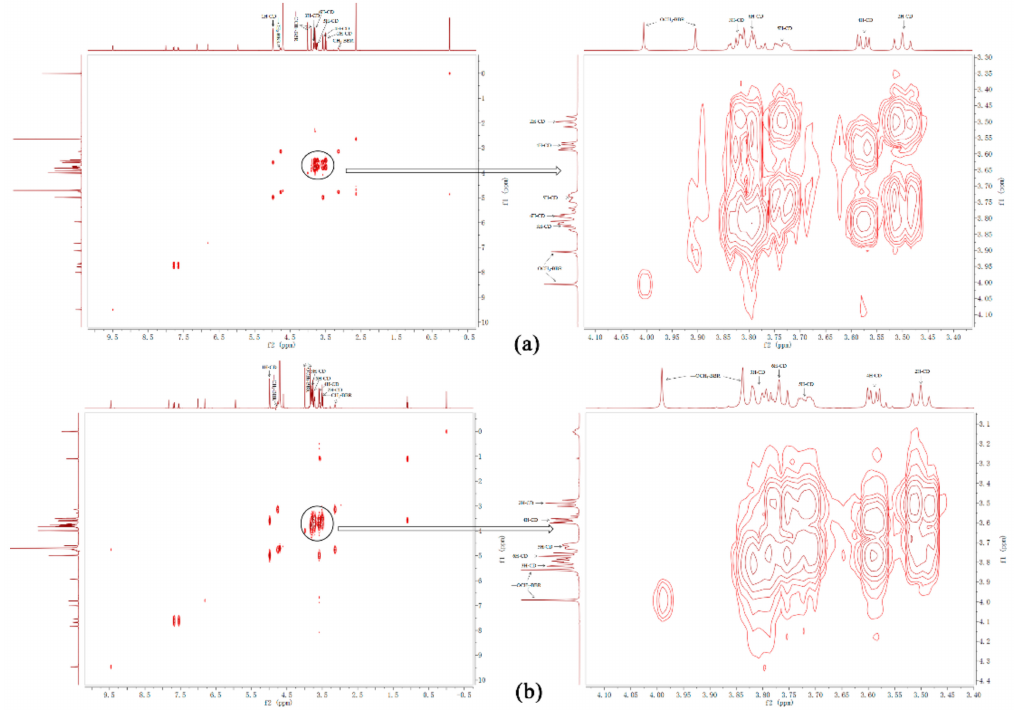
Figure 7. NOESY spectrum of ( a ) BP n Sample 2, and ( b )